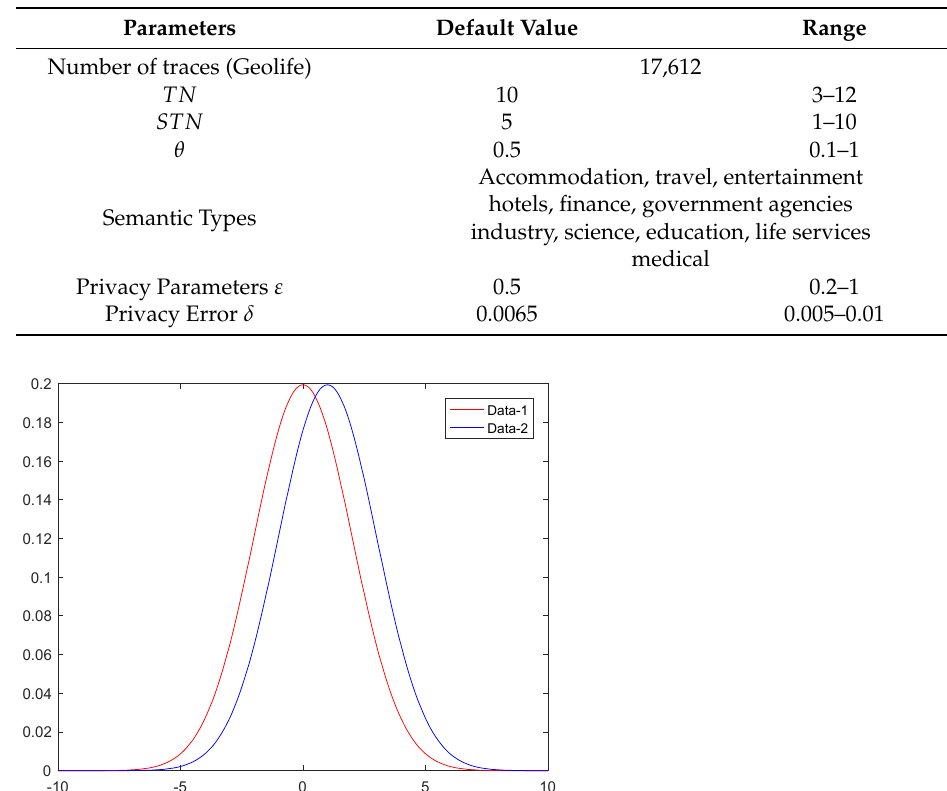
Table 1. Experimental parameter settings.